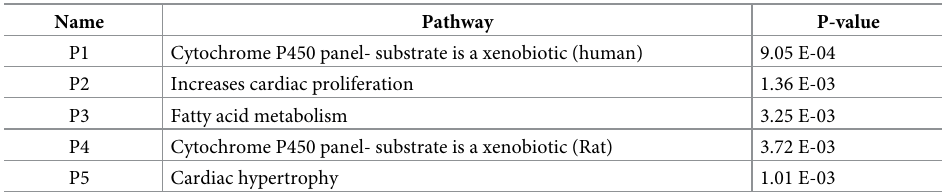
Table 2. The top toxicological